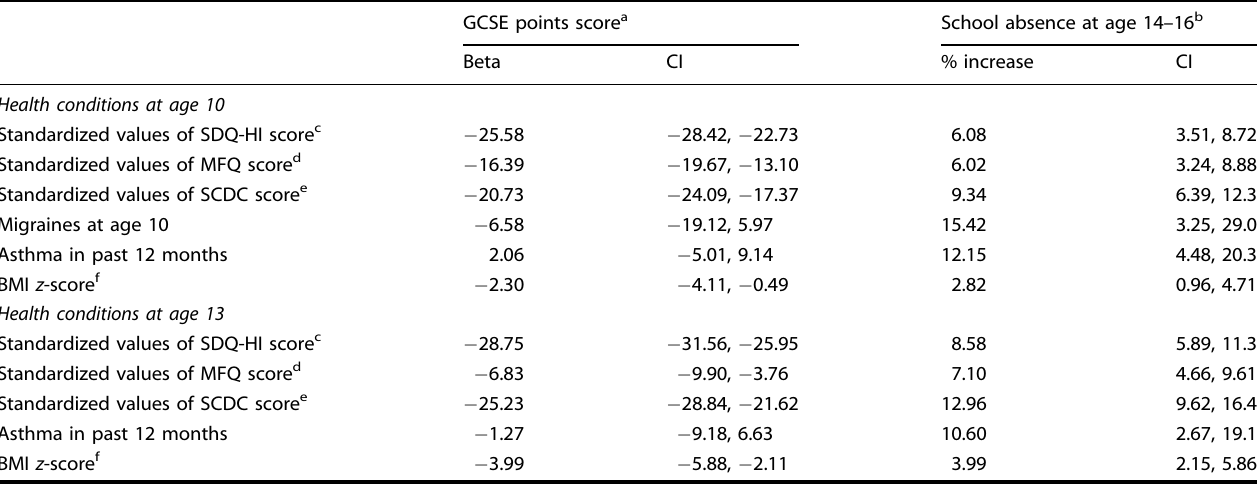
Table 2. Phenotypic associations of health conditions with educational attainment at 16 and school absence at 14 – 16 ( N =